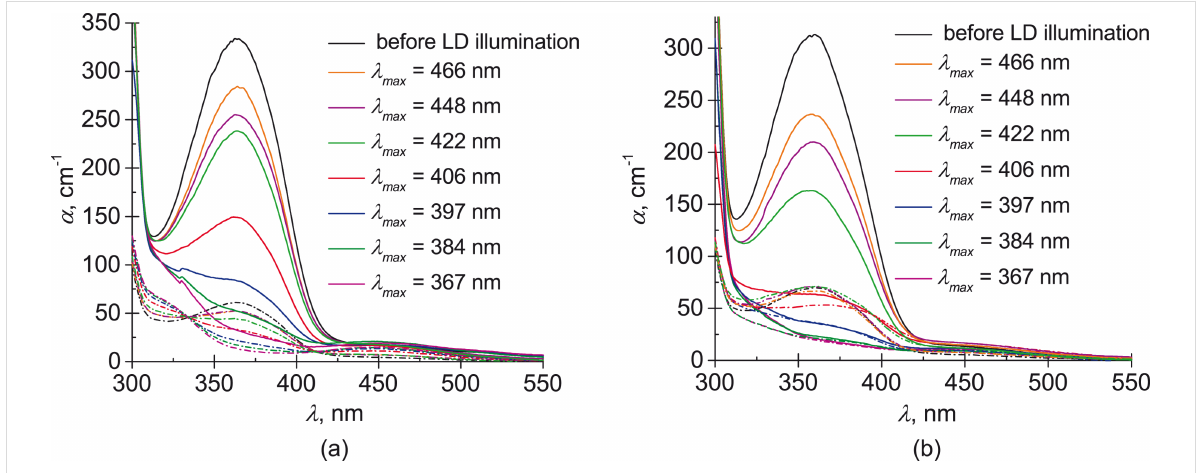
Figure 5: Absorption spectra of the extraordinary (solid curves) and ordinary (dashed curves) waves for (a) NLC doped with monomer M and (b) NLC doped with dendrimer G5 before and after LED illumination with λ max = 365, 384, 398, 405, 422, 448 and 466 nm.